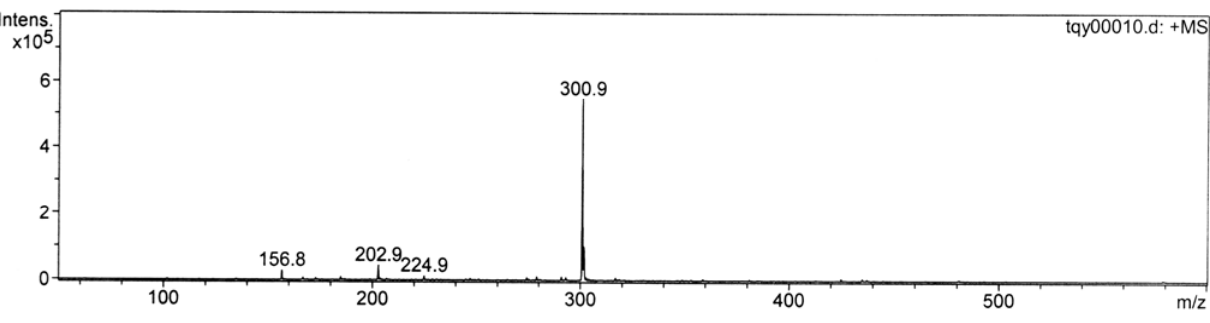
Figure 5. Mass spectrum of the Diels-Alder reaction